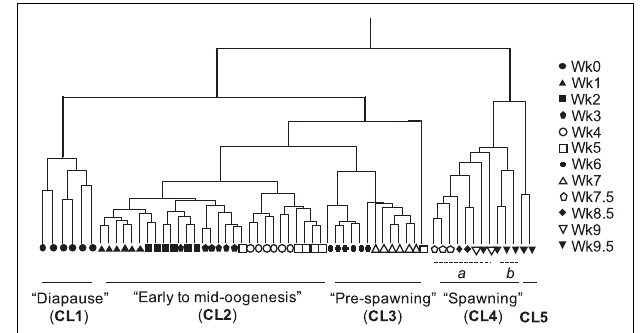
FIGURE 1 | Cluster analysis by gene expression profile of all transcripts in Neocalanus flemingeri adult females from collection (Wk0) to Wk9.5. Dendrogram of adult females ( n = 61) obtained by hierarchical cluster analysis based on relative expression of 85,505 transcripts ( > 1 cpm expression) showed four major clusters (CL1-CL4) and a fifth cluster (CL5) with only two females. Clusters have been named based on stage of reproductive program (Roncalli et al., 2018b) (see text). Each line represents a single adult female individual. One female (Wk5) did not cluster with any others, and this individual was removed from downstream analyses. Symbols indicate length of incubation time post collection (see legend in